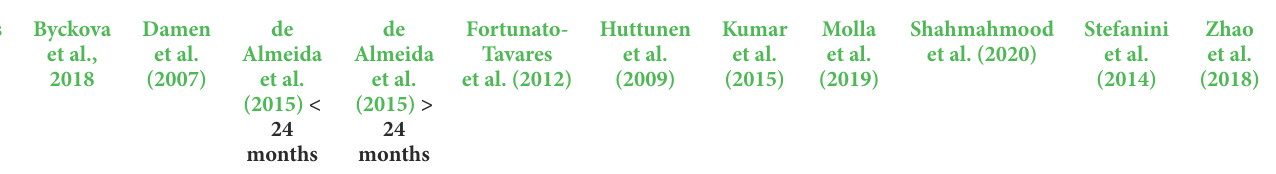
TABLE 3 Communication subscale Tukey HSD post-hoc mean